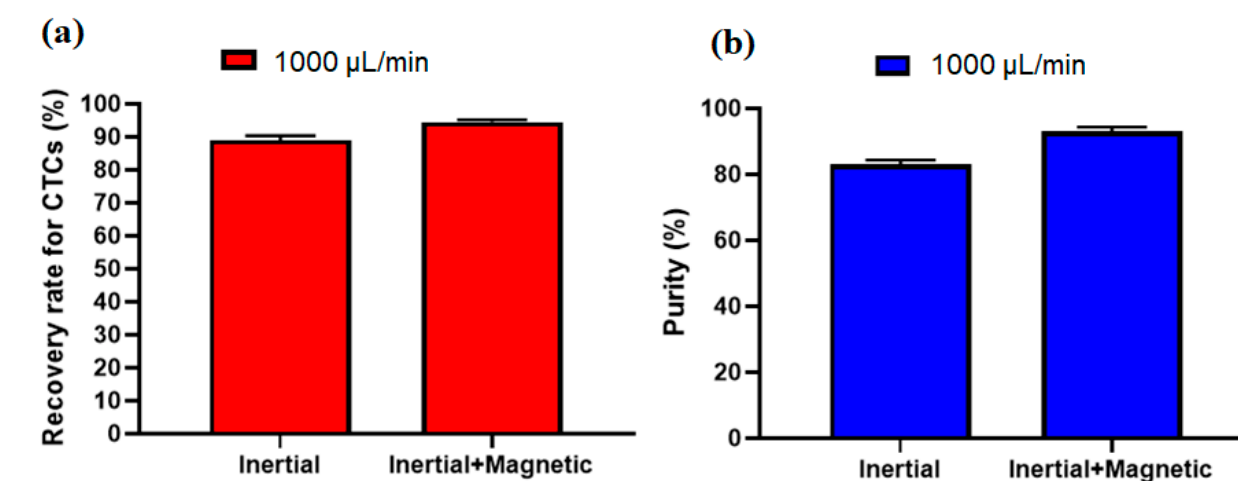
Figure 7. Comparison of the performance of the proposed device in terms of ( a ), recovery rate and ( b ), purity of separated CTCs for the inertial section as well as the inertial-magnetic hybrid device.